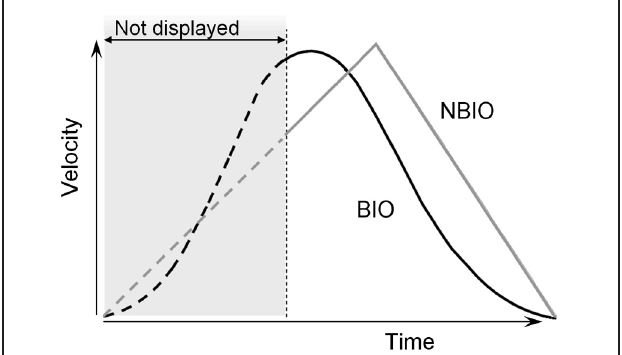
FIGURE 1 | Velocity profiles of the two laws of motion used in Experiments 1 and 2. Both laws are applied to a dot moving on the same straight upward trajectory. For the first kind of motion, the dot moved according to a standard biological rule (BIO black curve in the figure); this biological display is obtained by recording a vertical straight arm pointing movements. In the second kind of motion the stimulus moves accordingly to a triangular shaped velocity profile, characterized by a linear acceleration in the first 60% of the trajectory and a linear deceleration during the last 40% (NBIO gray curve in the figure). In Experiment 1 only the last 60% of the trajectory was visible, both for BIO and NBIO; in Experiment 2 the whole trajectory was